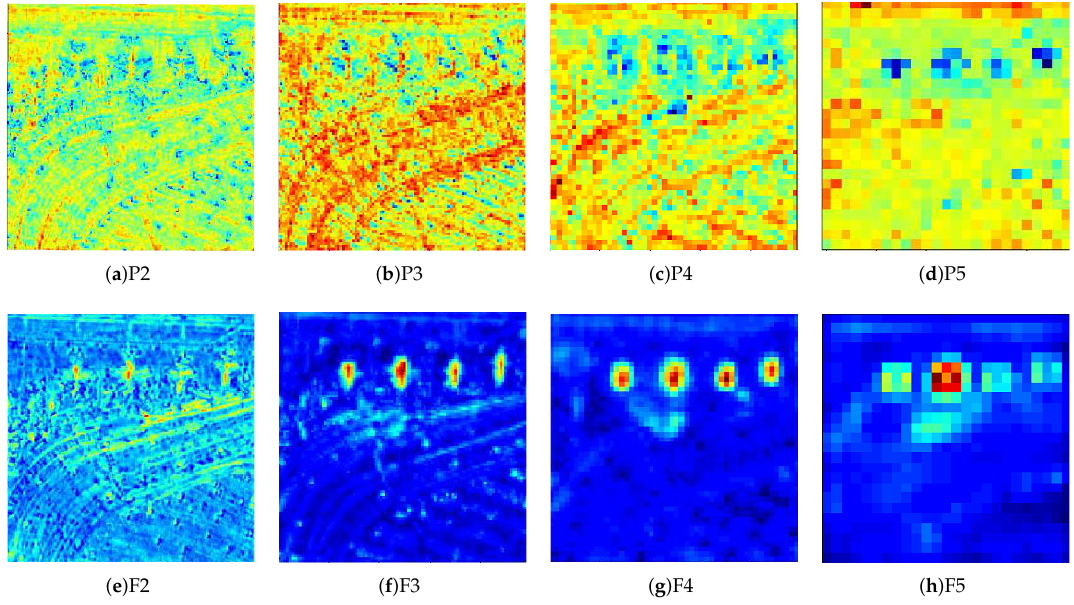
Figure 4. ( a )–( d ) represent the Feature map P2, P3, P4 and P5 respectively, ( e )–( h ) represent the corresponding F2, F3, F4 and F5 after AC